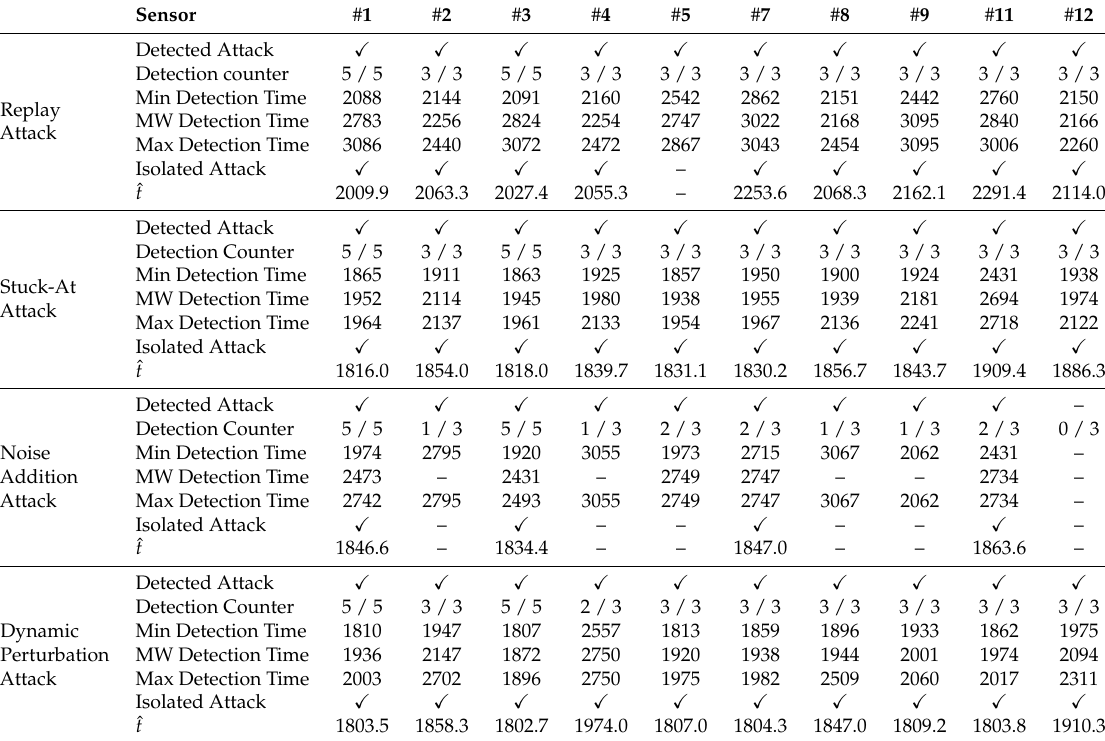
Table 5. Experimental results on the considered dataset: The symbol (cid:88) means that the attack has been detected/isolated, while the symbol – means that the attack has not been